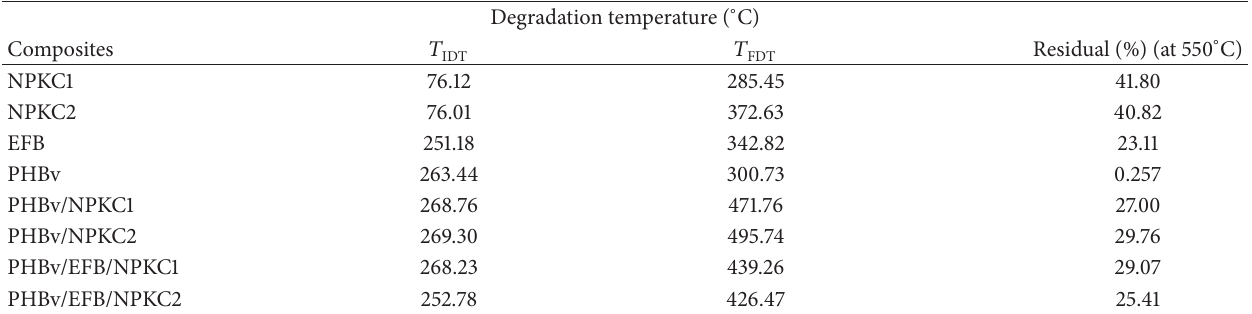
Table 2: TGA characterisation of pure PHBv, PHBv/NPK, and PHBv/NPK/EFB composites.